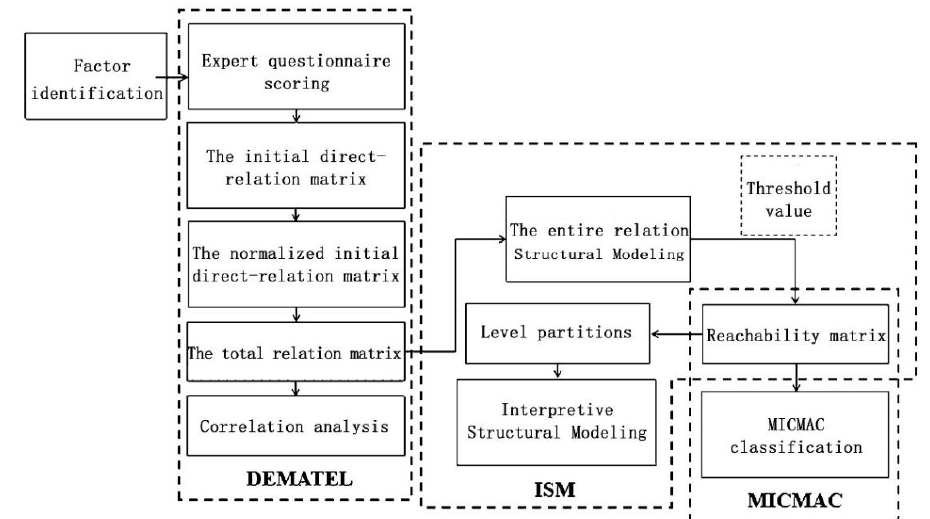
Figure 2. Method flowchart.